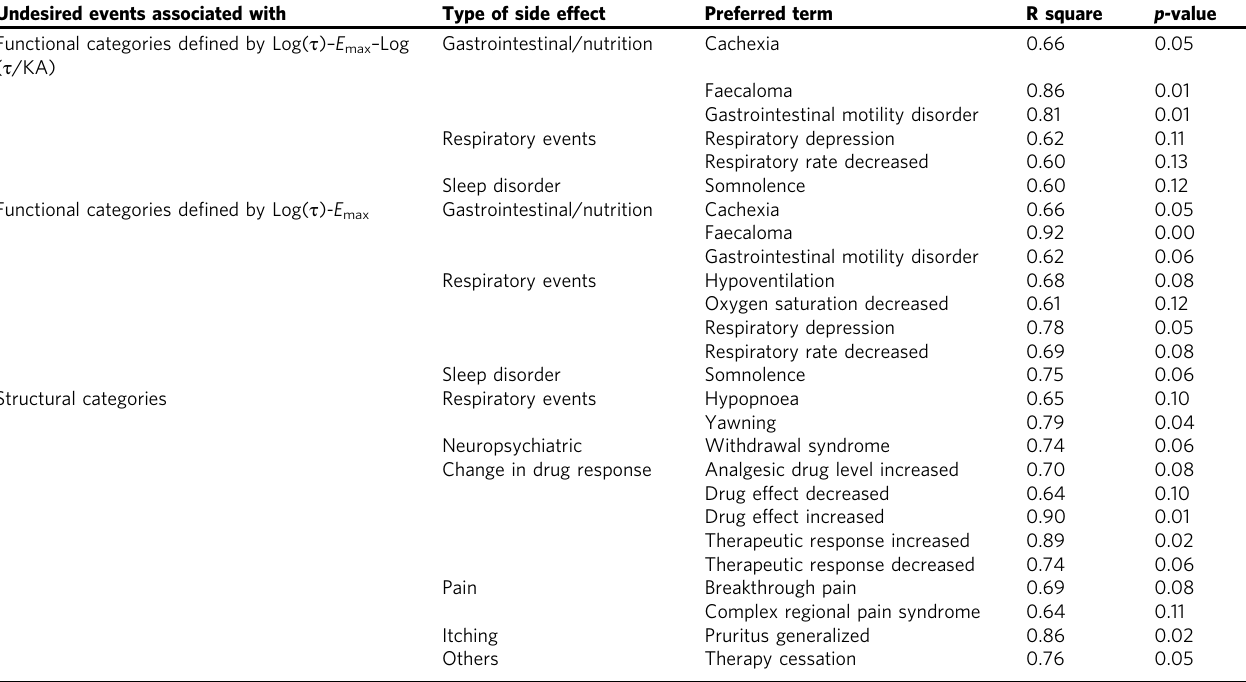
Table 1 Pharmacodynamic and structural categories associate with frequency of report of undesired events for clinically available hMOR ligands # Undesired events associated with Type of side